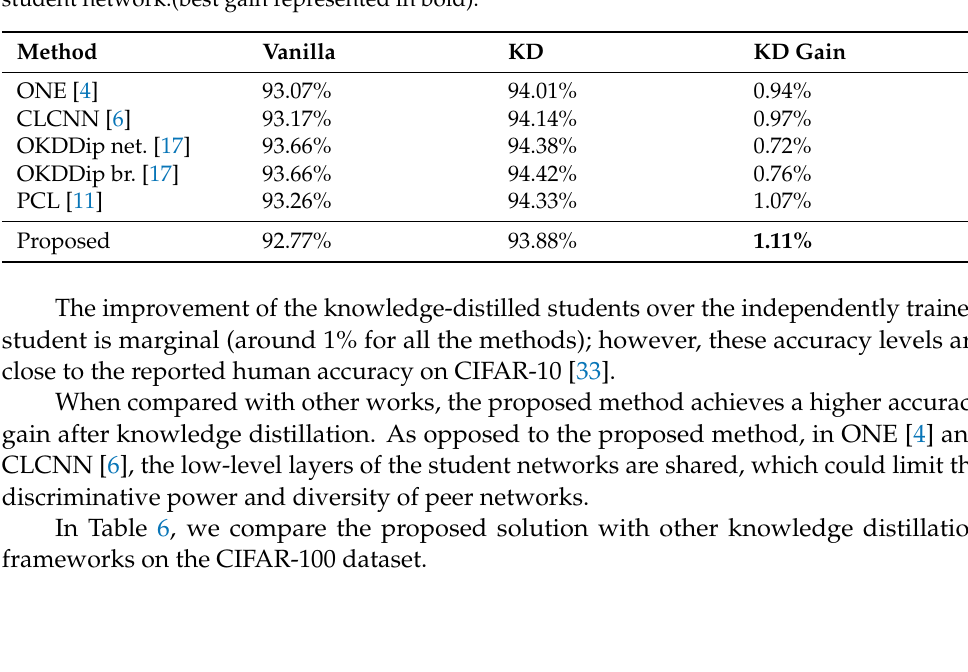
Table 5. Comparison with state-of-the-art works on CIFAR-10 database using ResNet-32 [22] as student network.(best gain represented in